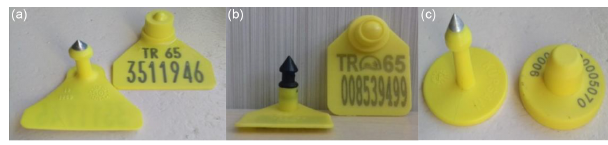
Figure 1. Metal-tipped (a) , plastic-tipped (b) , and electronic ear tag (c) applied in the